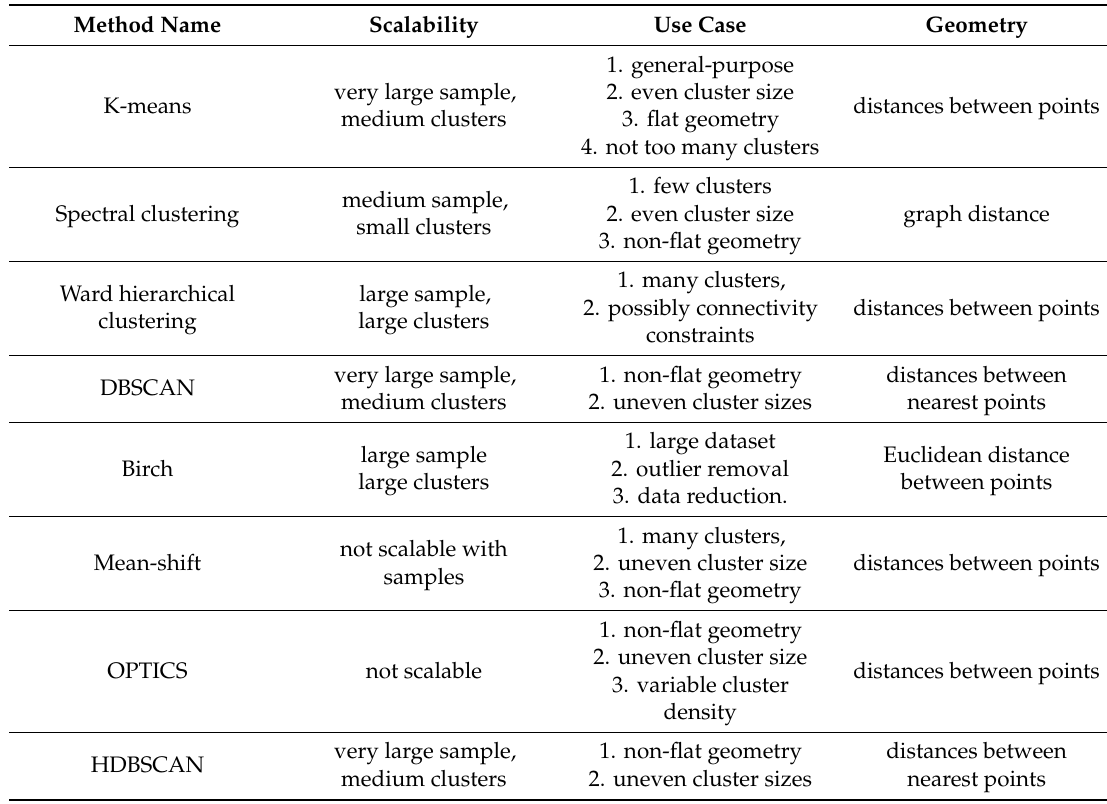
Table 1. Summary of clustering